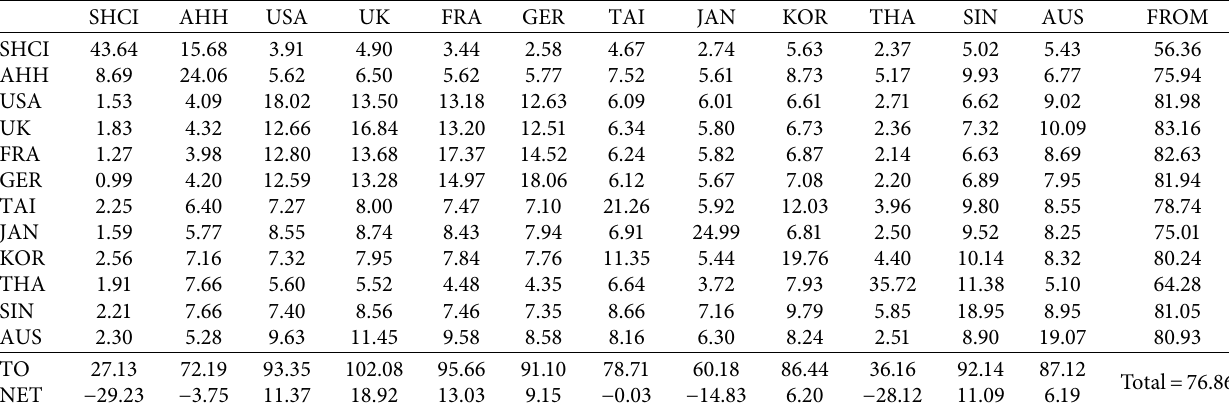
Table 5: Return spillover table of SHCI with other stock markets in the preperiod. SHCI AHH